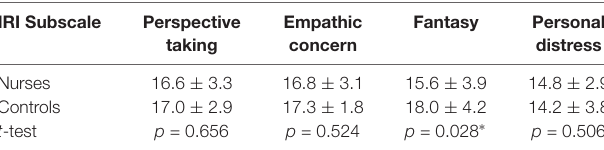
TABLE 1 | Interpersonal Reactivity Index (IRI) scores of the participants.